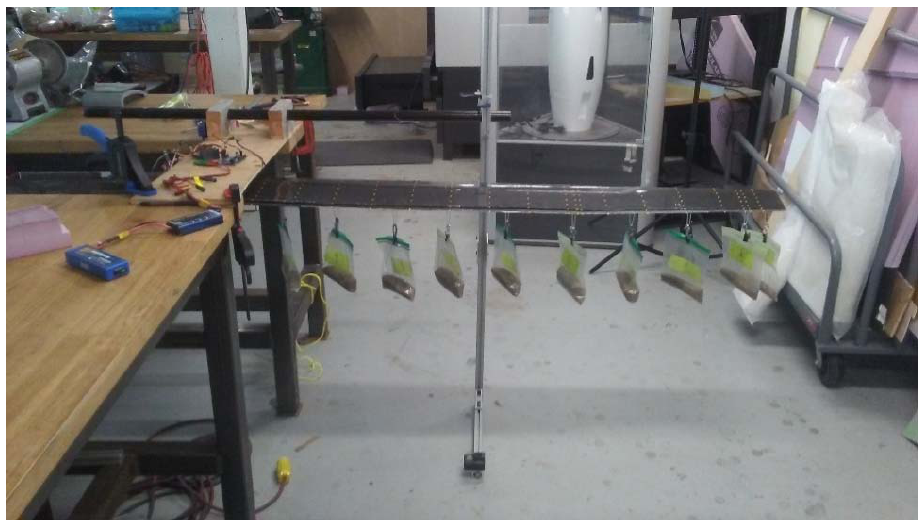
Figure 8. Test apparatus, lower surface up.